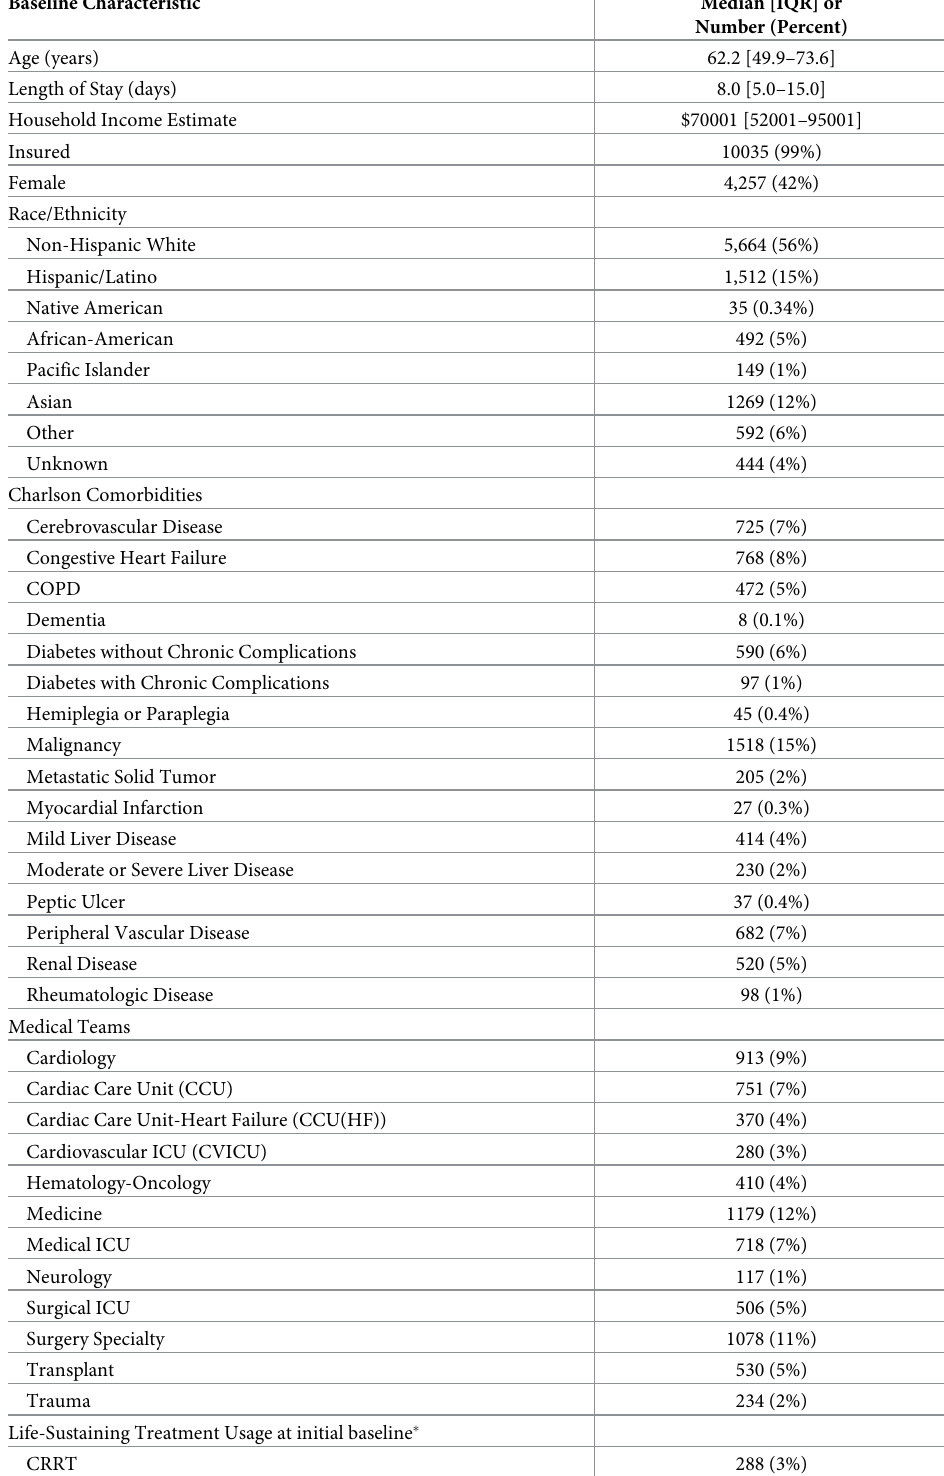
Table 1. Summary of patient and clinical characteristics (N =